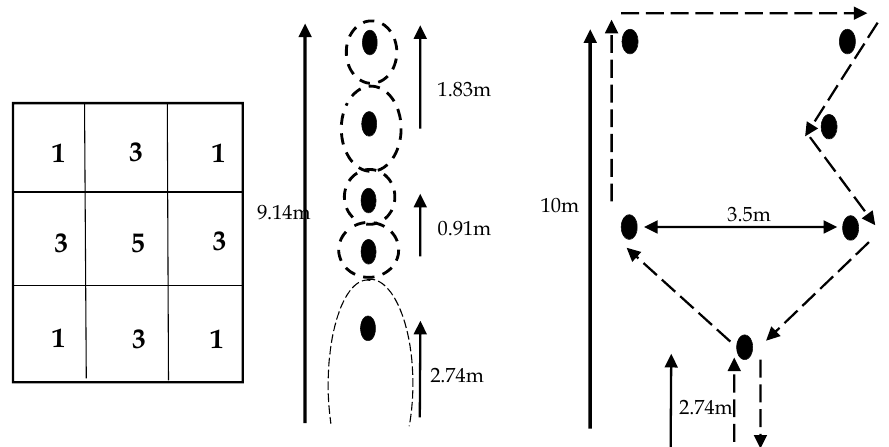
Figure 2. Schematic of the scoring grids for kicking accuracy ( left ), ball-dribbling ( middle ), and agility ( right ) protocols. Arrows represent the distance between the cones. Adopted from Currell et al., [25].